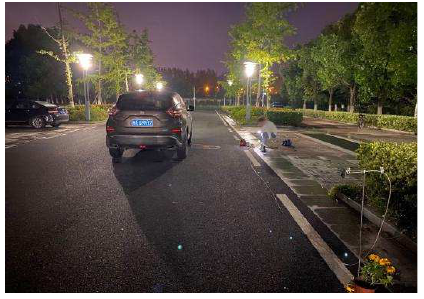
Figure 19. Velocity measurement experiment